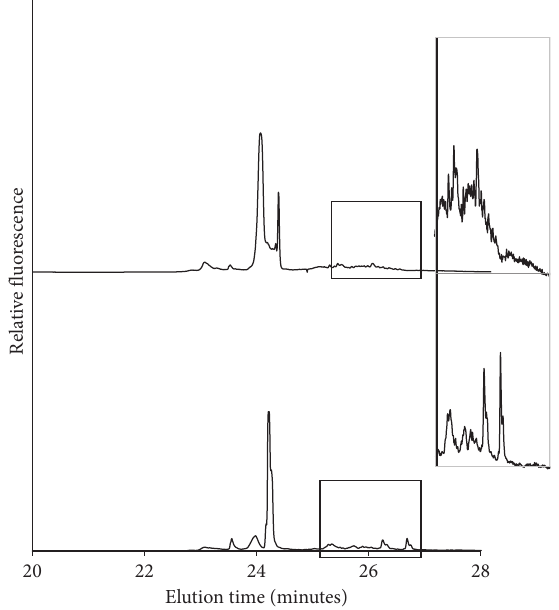
Figure 2: Electropherograms from initial tumor scan analysis. Two samples representing the same focus, one of which demonstrating detected mtDNA mutations in prostate tumor 3. The heteroduplex area is enlarged to illustrate 5% mutant fraction versus sample scored as (c) 3 variants-maximum 9 peaks (Figure 3(b))